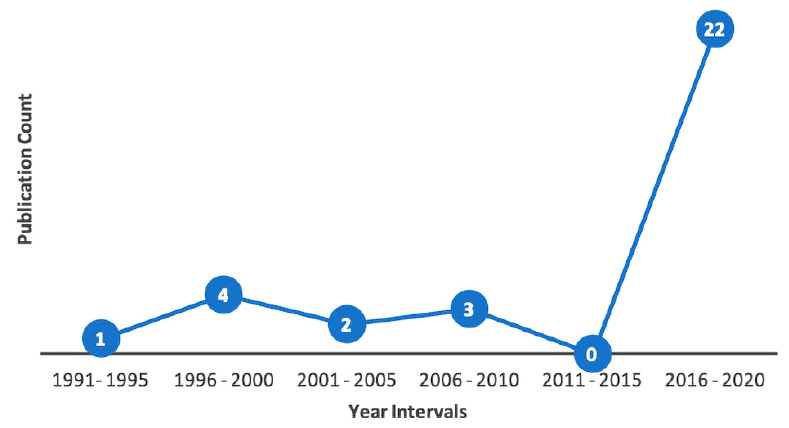
Figure 2. Publication count per time interval of all articles included in the review.